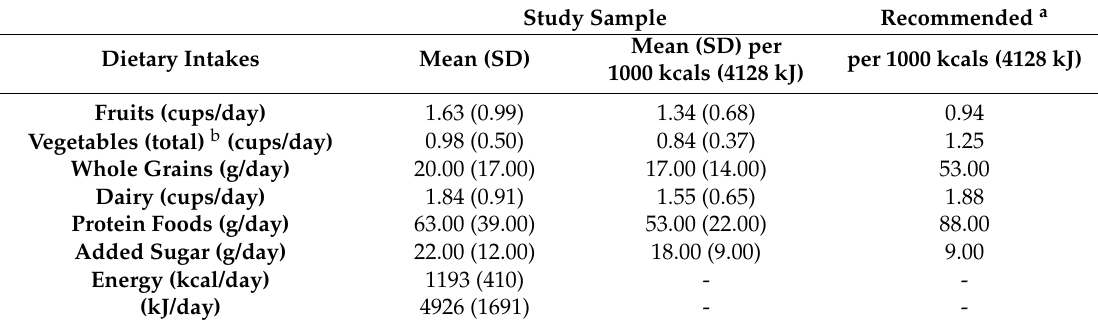
Table 3. Dietary intakes from the Block Kids Last Week Food Screener ( n =